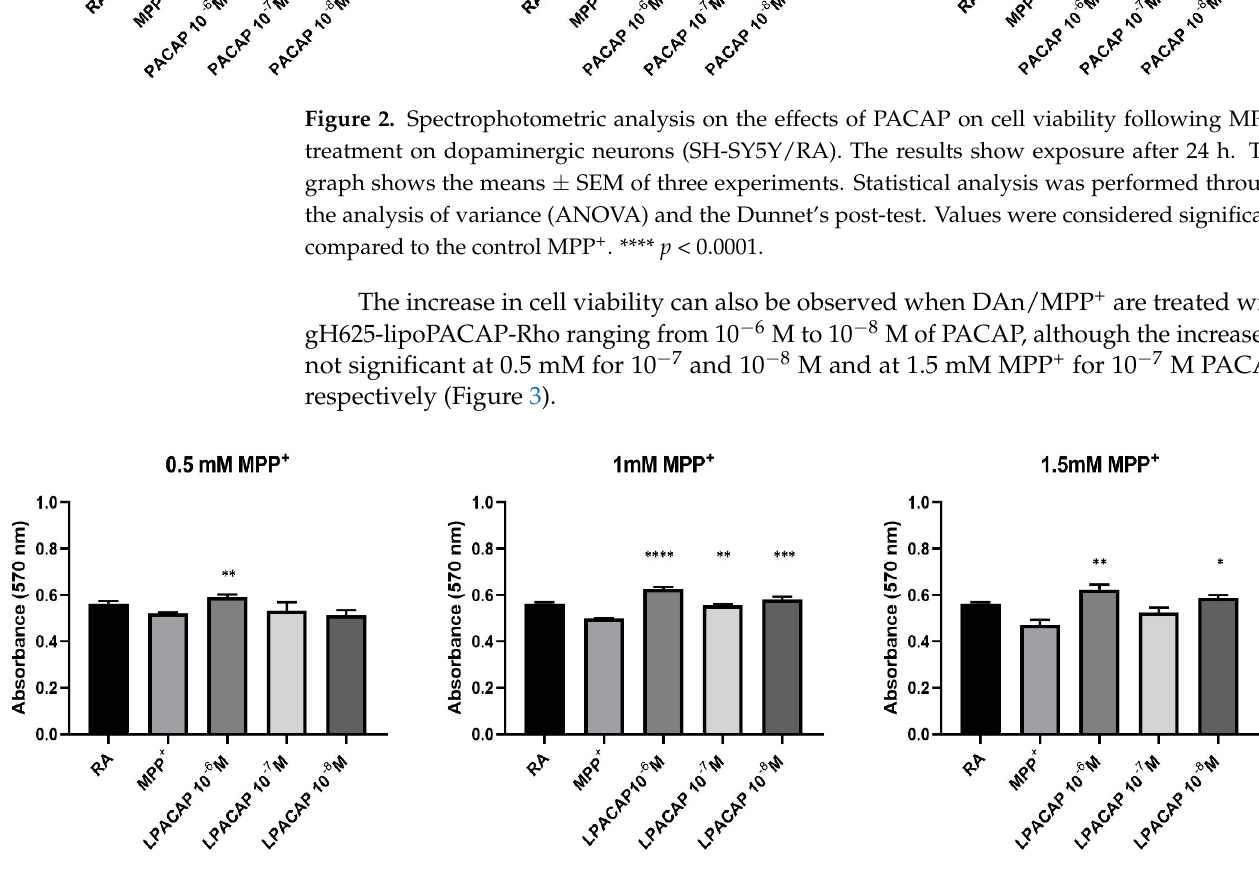
Figure 3. Spectrophotometric analysis on the effects of gH-lipoPACAP-Rho (LPACAP) on cell viability following MPP + treatment on dopaminergic neurons (SH-SY5Y/RA). The results show exposure after 24 h. The graph shows the means ± SEM of three experiments. Statistical analysis was performed through the analysis of variance (ANOVA) and the Dunnet’s post-test. Values were considered significant, compared to the control MPP + . * p < 0.05, ** p < 0.01, *** p < 0.001, **** p <